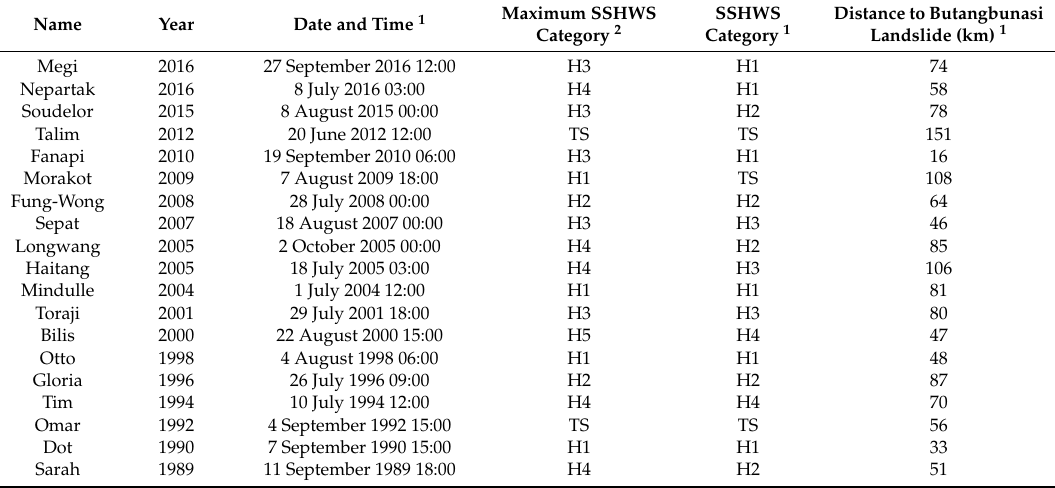
Table 2. Selected typhoon and tropical storm events for the